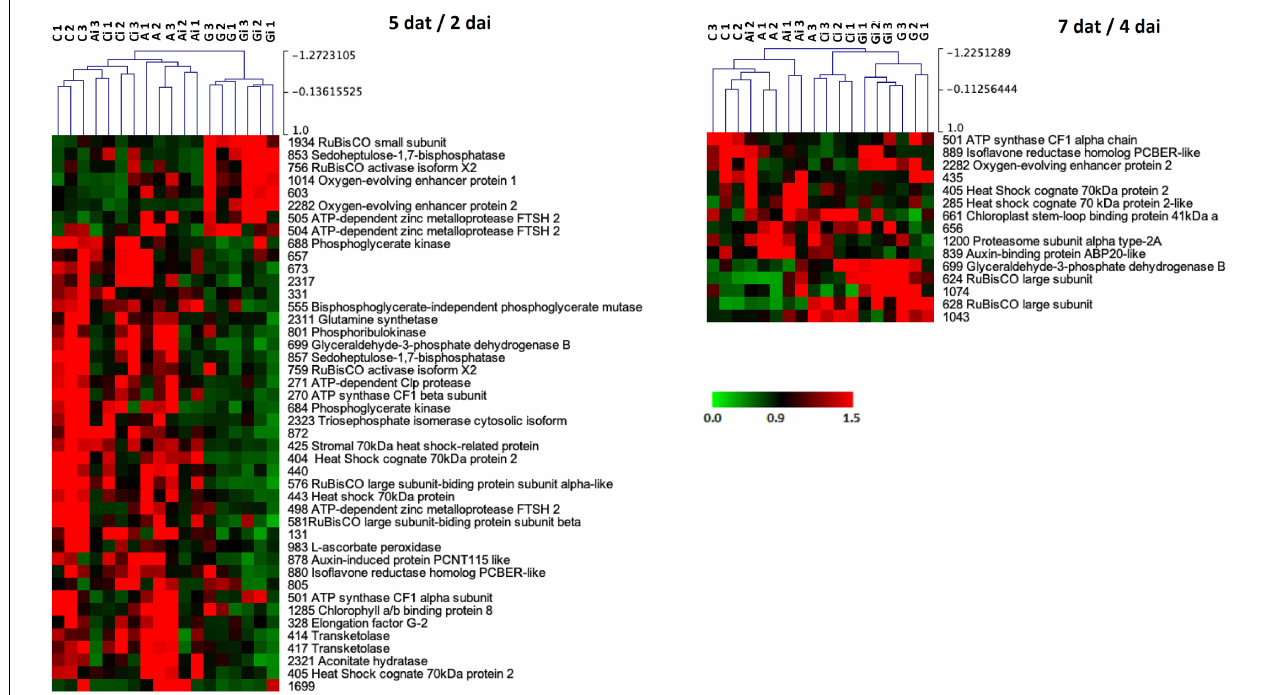
FIGURE 9 | Hierarchical cluster analysis of the proteins that significantly changed in abundance ( p -value < 0.05) between Greenforce CuCa (G), ASM (A), and Control (C) and treated and inoculation (i) with H. vastatrix, (Ci, Gi, Ai), at 5dat/2dai and 7dat/4dai. The signals are shown in a red-green color scale, from a gradient of red (higher expression) to green (lower